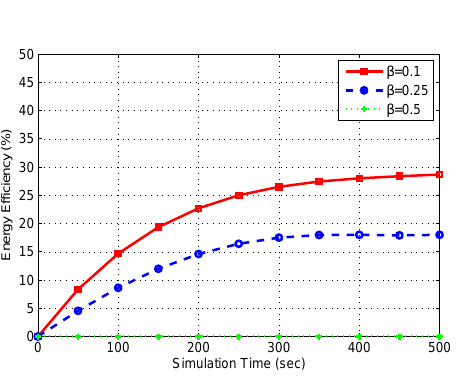
Figure 8. Unsatisfactory vehicle percentage w.r.t. traffic density. Figure 9. Energy efficiency w.r.t. simulation